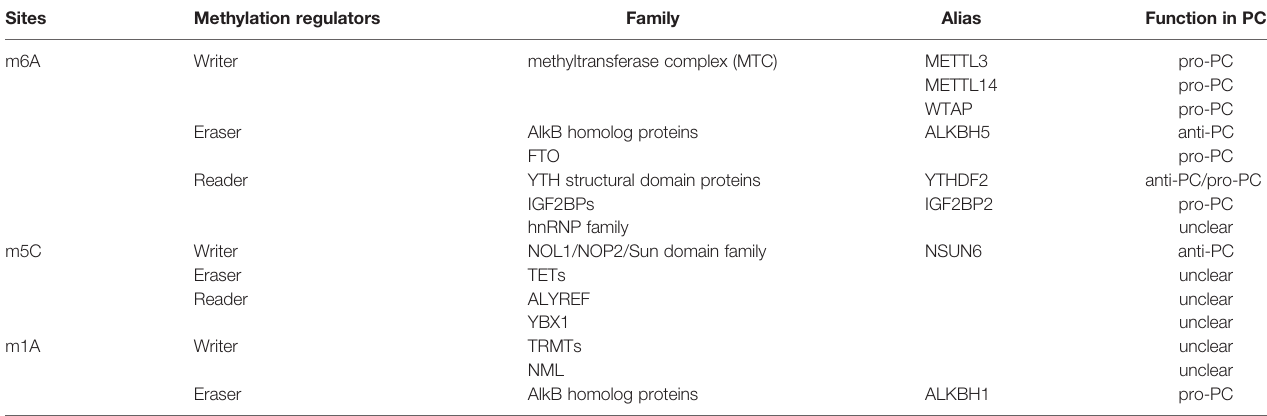
TABLE 3 | Major groups of RNA methylation regulators in